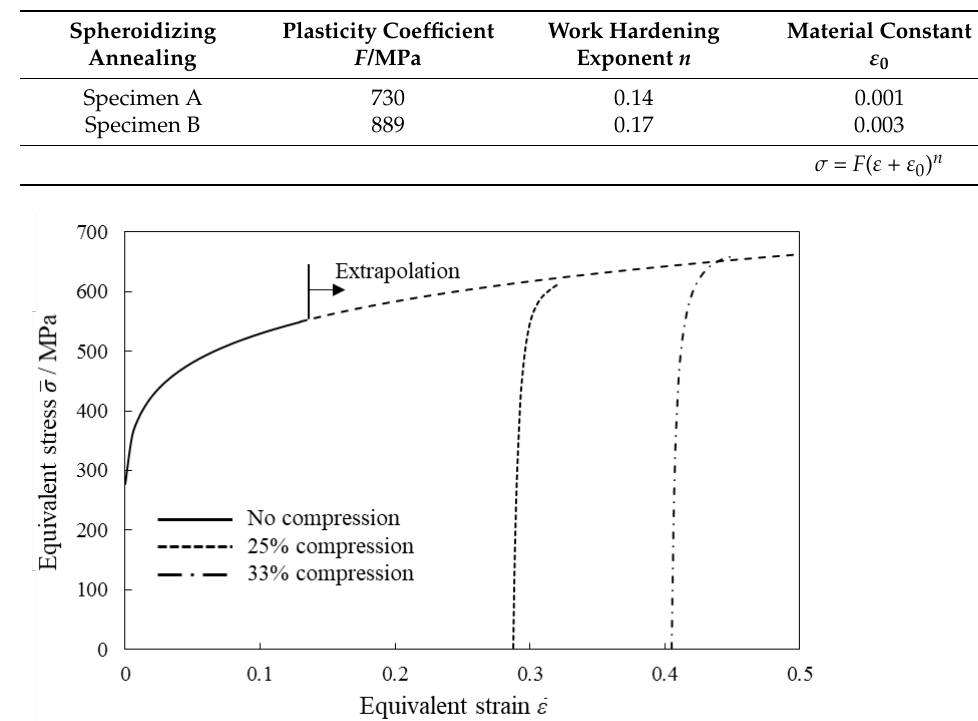
Figure 6. Stress-strain curve of Specimen A.